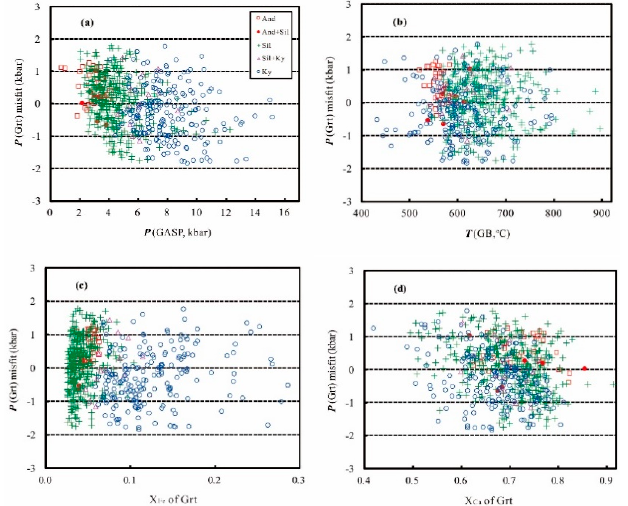
Figure 3. Distribution of the pressure misfit of the present garnet geobarometer based on the calibrant metapelite samples (Table S1). P (Grt) misfit of the present garnet geobarometer is defined as the pressure difference determined by the garnet (this work) and the GASP [49] geobarometers. ( a ) Misfit vs. pressure; ( b ) misfit vs. temperature; ( c ) misfit vs. X Fe of garnet; and ( d ) misfit vs. X Ca of garnet.